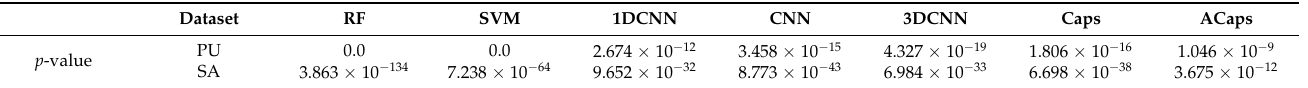
Table 5. The McNemar’s test results ( p -value) derived from the quantitative comparisons of accuracy between the PAR- ACaps and the benchmarks (RF, SVM, 1DCNN, CNN, 3DCNN, Caps, and ACaps).